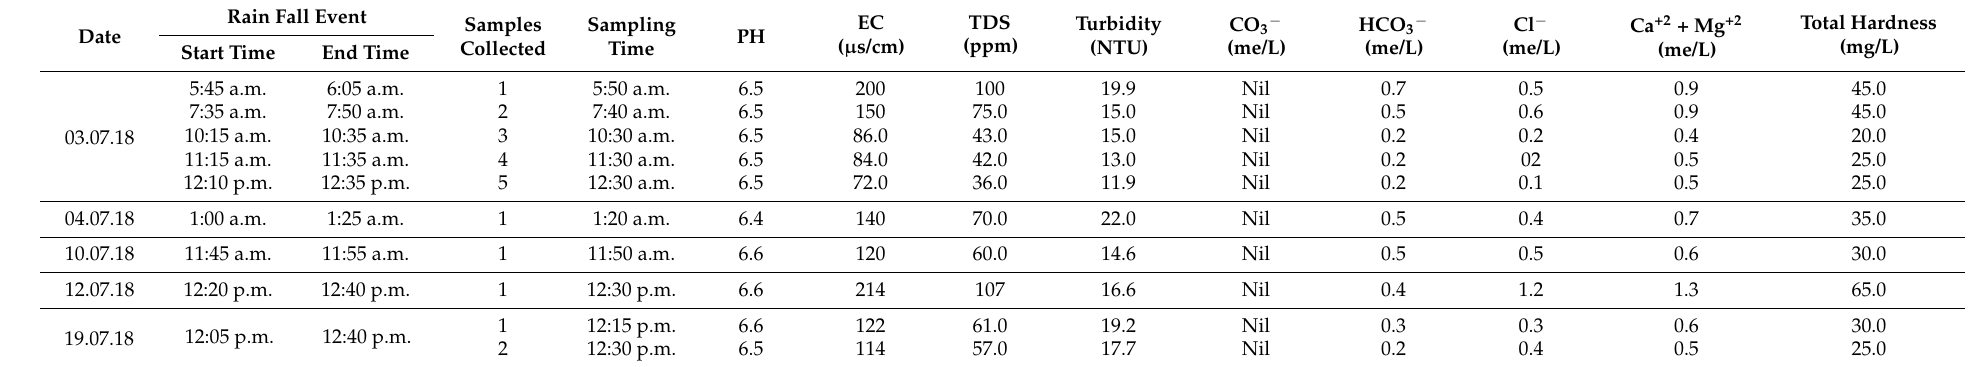
Table A8. Street run off rain samples collected from Site 2.